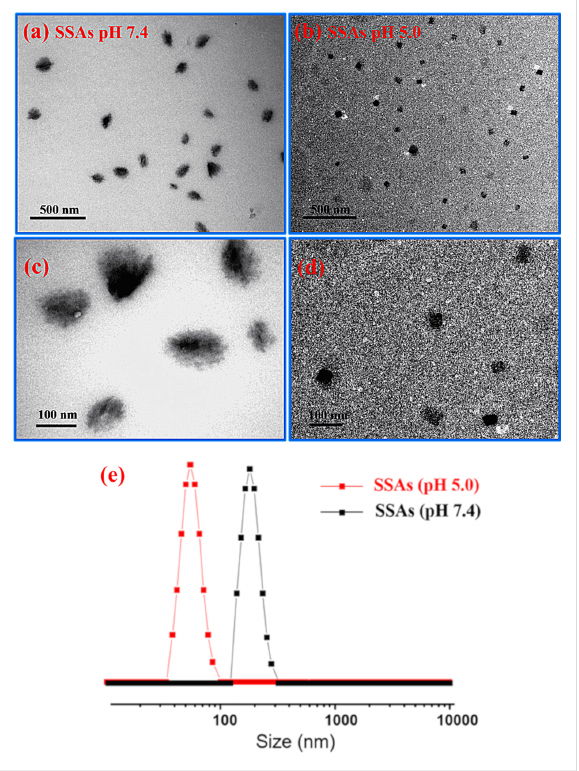
Figure 1: Typical TEM images (a–d) and DLS curves (e) of β -CD-BM 2 - based supramolecular self-assemblies at pH 7.4 (a, c, e) and pH 5.0 (b, d, e),